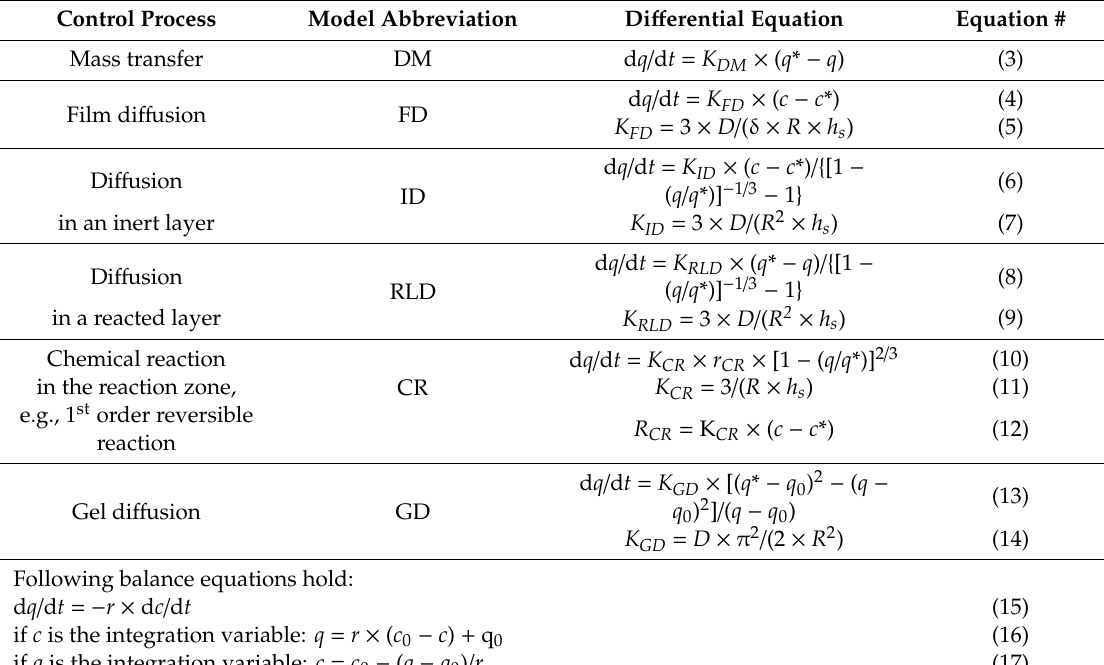
Table 1. Kinetic models of sorption / extraction taking place in two-phase systems